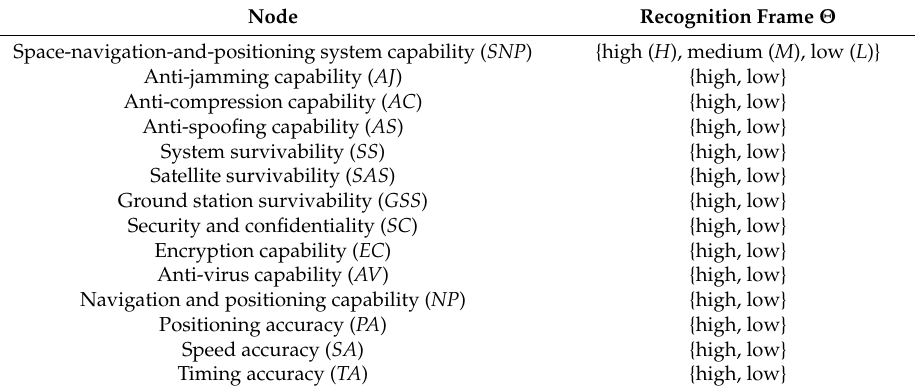
Table 1. Identification framework for space navigation and positioning capabilities.